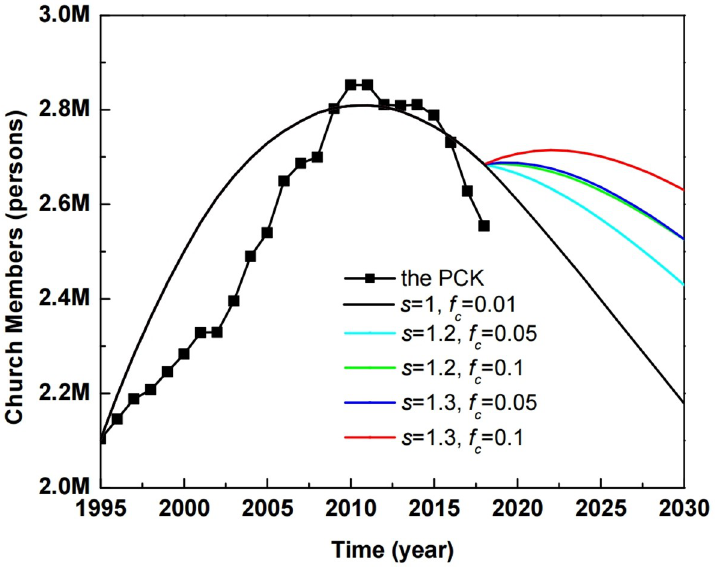
Fig 8. Baseline scenario (solid line) with s = 1 and f c = 0.01 compared to the historical population of the PCK from 1995 to 2018 (solid squares). Scenario 1 for s = 1.2 is shown with cyan and green solid lines, when f respectively. Scenario 2 for s = 1.3 appears with blue and red solid lines when f c = 0.05 and 0.1, respectively (S9